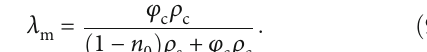
Figure 7: Comparison of the theoretical value and test value of cement particle mass content λ C = 1 : 0 ; (c) W / C = 1 : 2